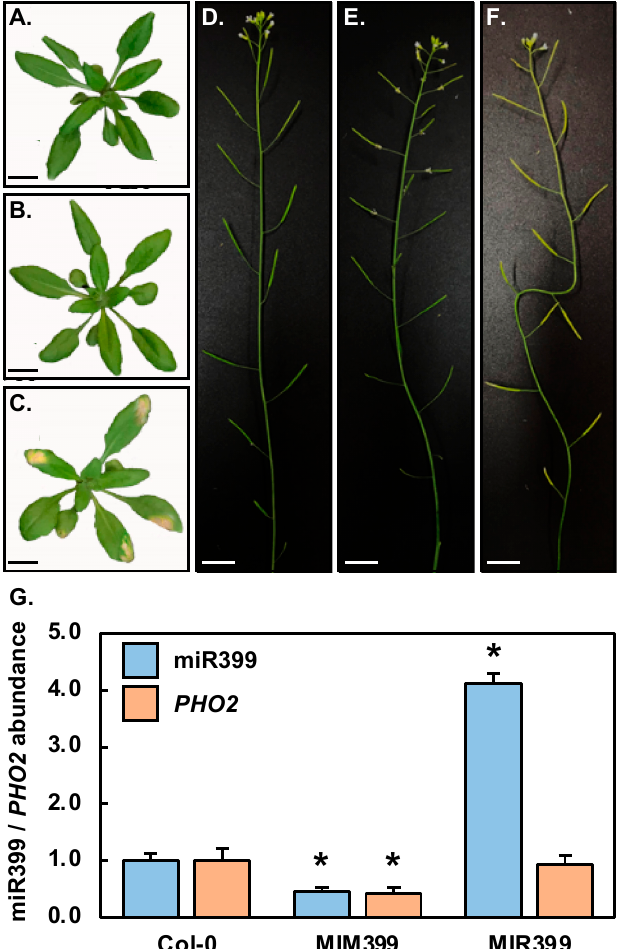
Figure 1. Arabidopsis transformant lines, MIM399 and MIR399 plants, molecularly modified to have altered miR399 abundance. Vegetative phenotypes displayed by 25-day-old Col-0 ( A ), MIM399 ( B ) and MIR399 ( C ) plants. ( A – C ) Scale bar = 1.0 cm. The primary inflorescence and siliques of 40-day-old Col-0 ( D ), MIM399 ( E ) and MIR399 ( F ) plants. ( D – F ) Scale bar = 2.0 cm. ( G ) RT-qPCR quantification of miR399 abundance and the expression of its target gene, PHO2 , in the rosette leaves of 25-day-old Col-0, MIM399 and MIR399 plants. Error bars represent the standard deviation of four biological replicates and the presence of an asterisk above a column represents a statistically significant difference in the abundance of either miR399 or its PHO2 target transcript between MIM399 , MIR399 and Col-0 plants ( p -value: * < 0.05). To determine whether the MIM399 and MIR399 transformant lines selected for further experimental characterization had altered miR399 abundance, and/or PHO2 target gene expression, RT-qPCR was used to quantify the levels of the miR399 and PHO2 transcripts in MIM399 and MIR399 plants. This analysis revealed that miR399 abundance was reduced by 2.2-fold in the rosette leaves of MIM399 plants, compared to its abundance in Col-0 rosette leaves (Figure 1G). In response to reduced miR399 abundance, PHO2 target gene expression was also determined to be reduced to a similar degree, down by 2.4-fold, in the rosette leaves of MIM399 plants. This formed an unexpected finding considering that the predominant mode of plant miRNA target gene expression regulation is messenger RNA (mRNA) cleavage [28,29]. Therefore, the level of the PHO2 target transcript was